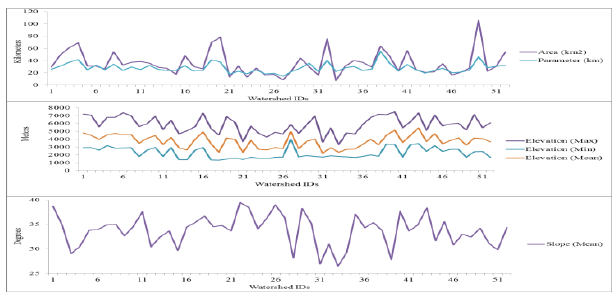
Figure 3: Goe-Features of the study Area